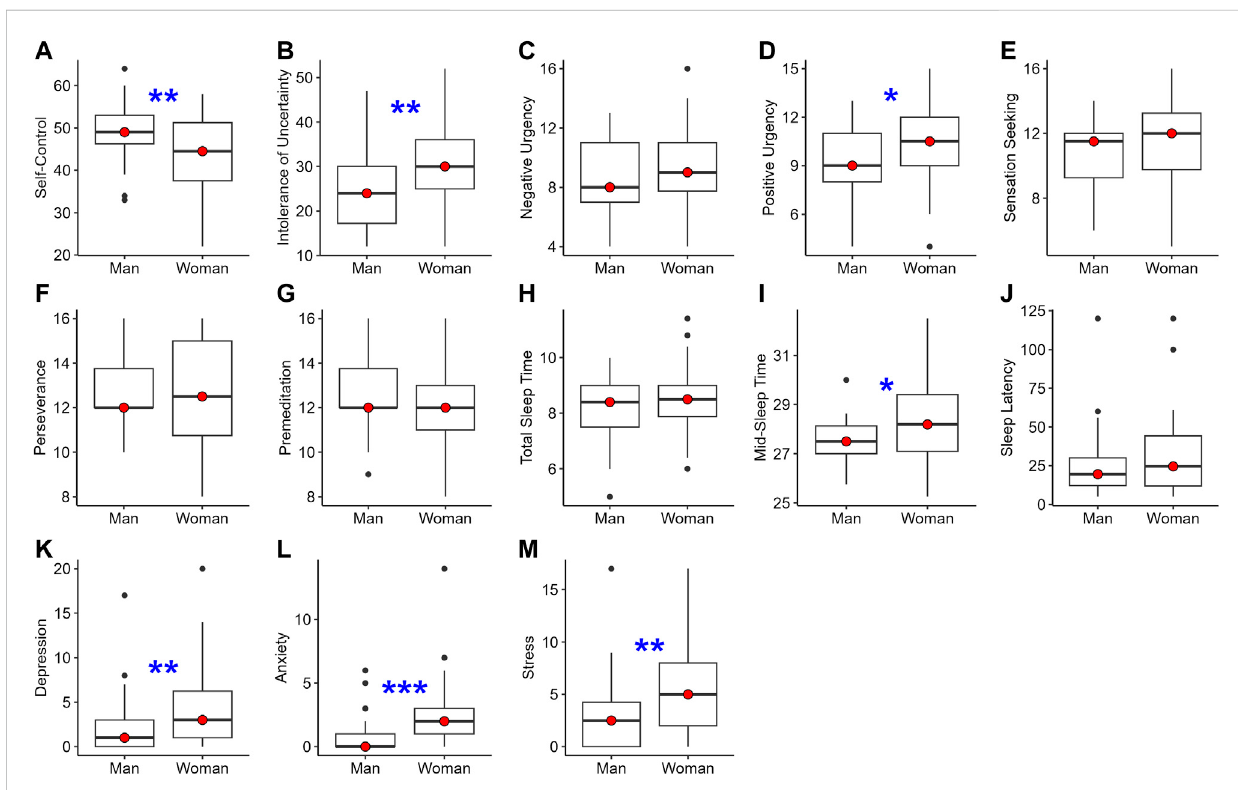
A visual representation of descriptive statistics for each measure (see each y-axis for Panels (A – M) ). Separate box plots are plotted for men and womenathletes.Thethicklinewiththeshadedcircleinitscenterrepresentsthemedian.Theboxrepresentsthemiddle50%ofthedata(i.e.,from25thto 75th percentile). The lines extended from the box go to the minimum and maximum of the data, excluding outliers (represented by dots). Stars between the boxes represent signi fi cant differences in the measure assessed by independent t-tests or Mann-Whitney U tests. * p < 0.05; ** p < 0.01; *** p < 0.001.